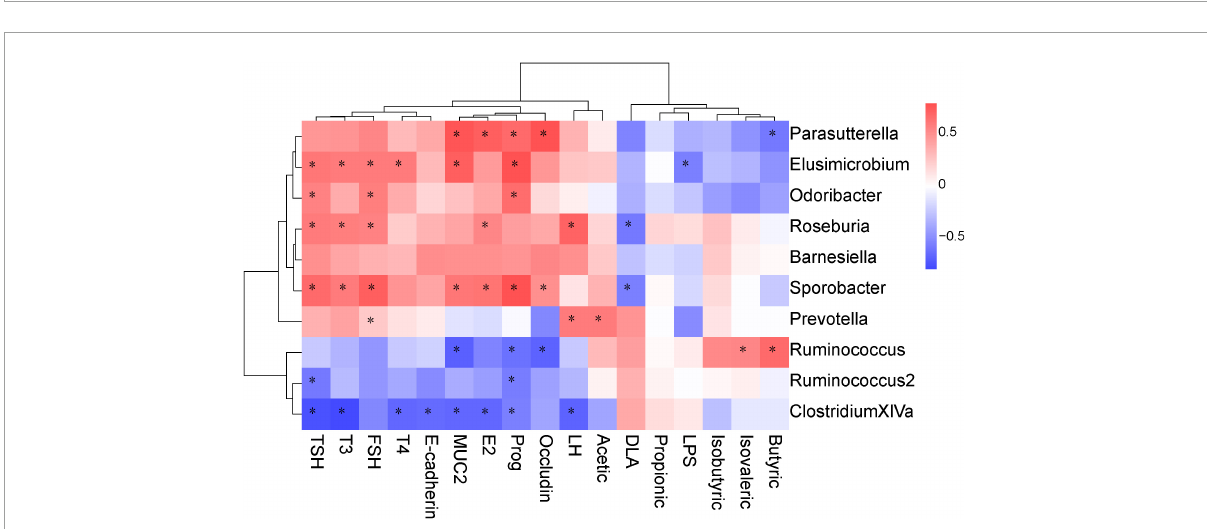
FIGURE10 Correlations between the biochemical indicators and the operational taxonomic units (OTUs). The intensity of the color indicates the degree of correlation between the OTU abundance and the biochemical indicator as evaluated by Spearman’s correlation. Significant correlations are indicated with an asterisk ( ∗ ) in the squares. The OTU taxonomy is listed on the